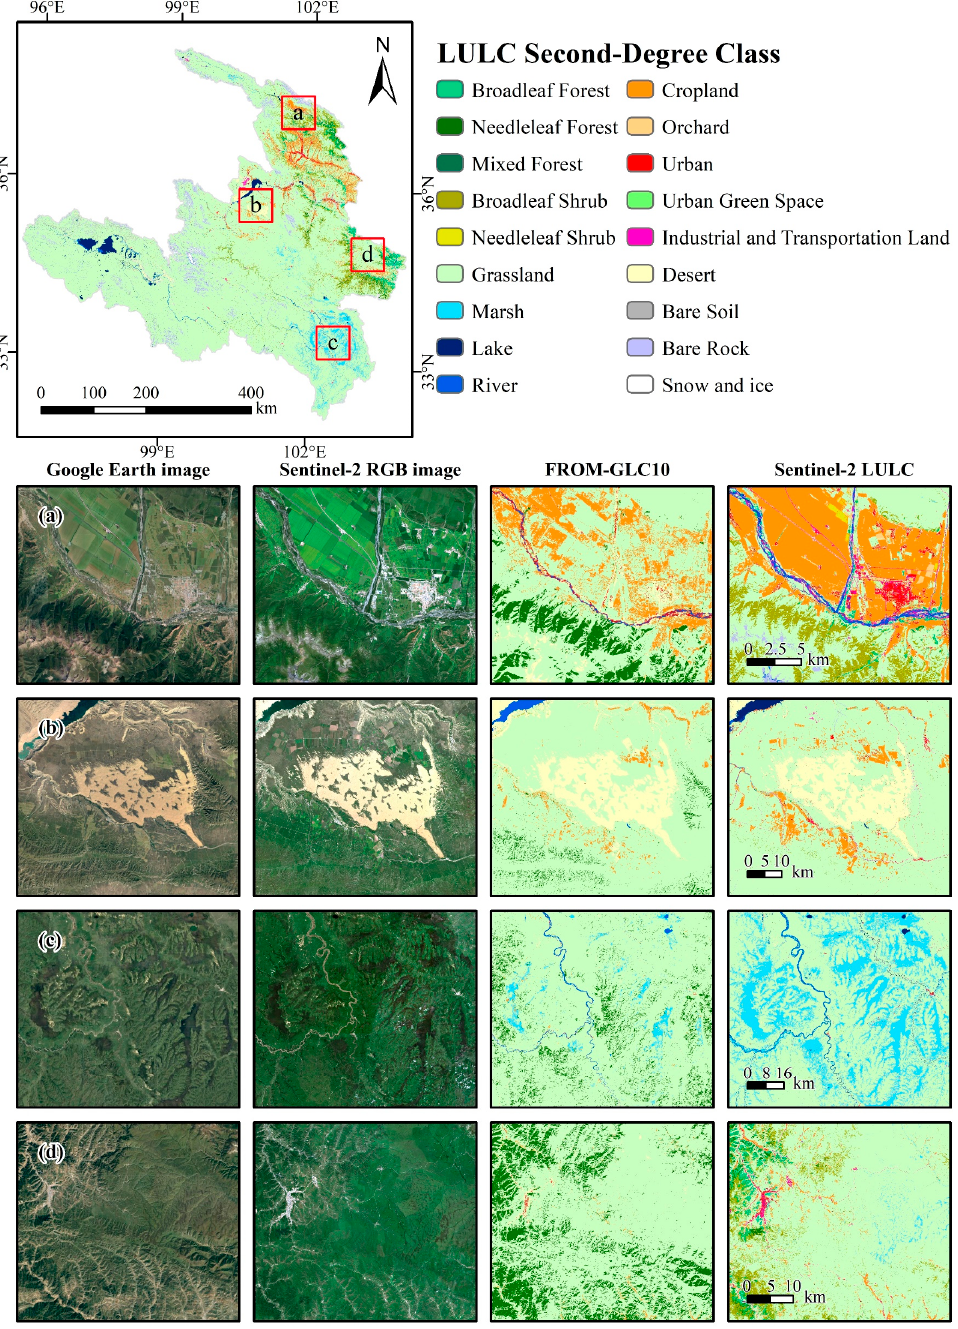
Figure 8. Visual comparison of this study with Google Earth, Sentinel-2 RGB, and FROM-GLC10 products. ( a – d ) Four typical areas were selected for close-ups.